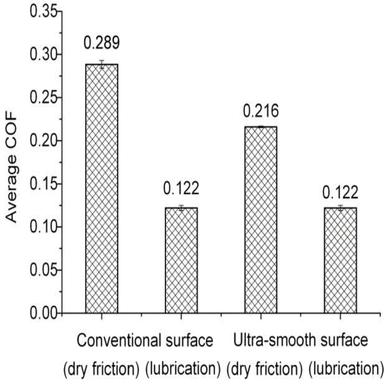
Average COF of the samples surfaces under different conditions.